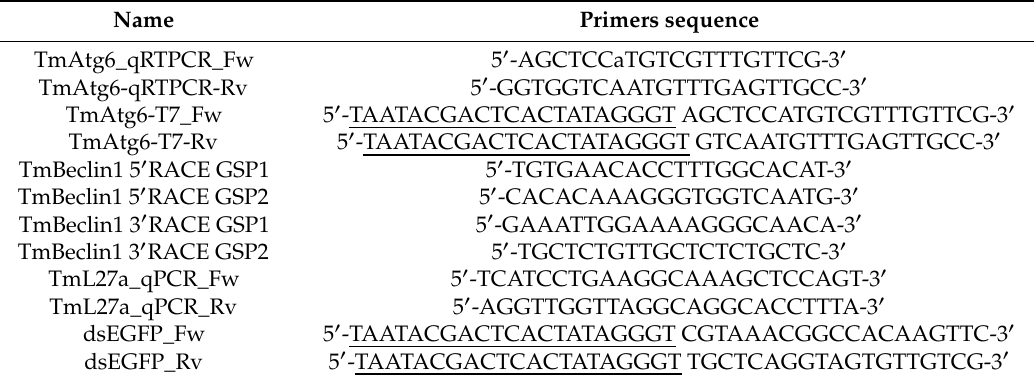
Table 1. Sequences of the primers used in this